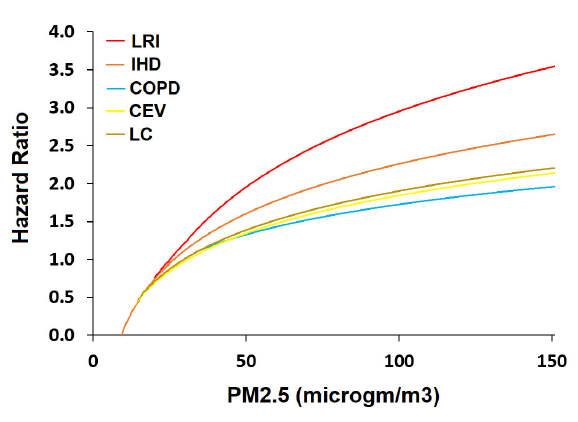
Figure 3 . Relationship between PM 2.5 concentration and hazard ratio of selected diseases.